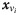
The structure of the forward RNN for each observed variant for the case of four stacked RNN cells.xvi and xvi+1 are input feature vectors for observed variants vi and vi+1, respectively. si,j(f) is the state of the RNN cell of the jth layer for observed variant vi and used as the input of the state for the RNN cell of the jth layer for observed variant vi+1. The output of the RNN cell of the top layer, oi,4, is handled as the output of RNN for each observed variant.